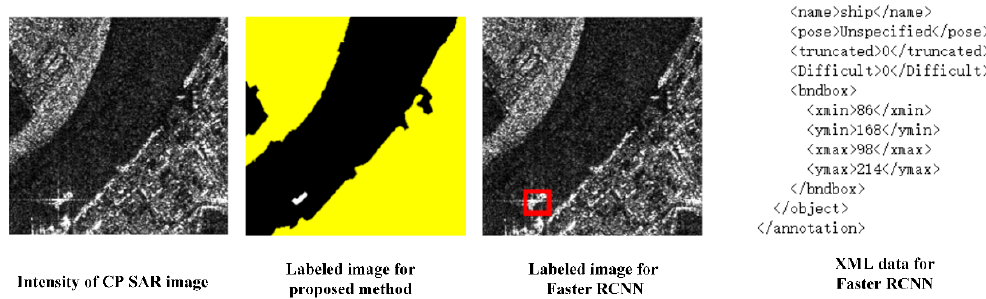
Figure 5. The train-loss curves of the U-Net training progress (with an average smooth).